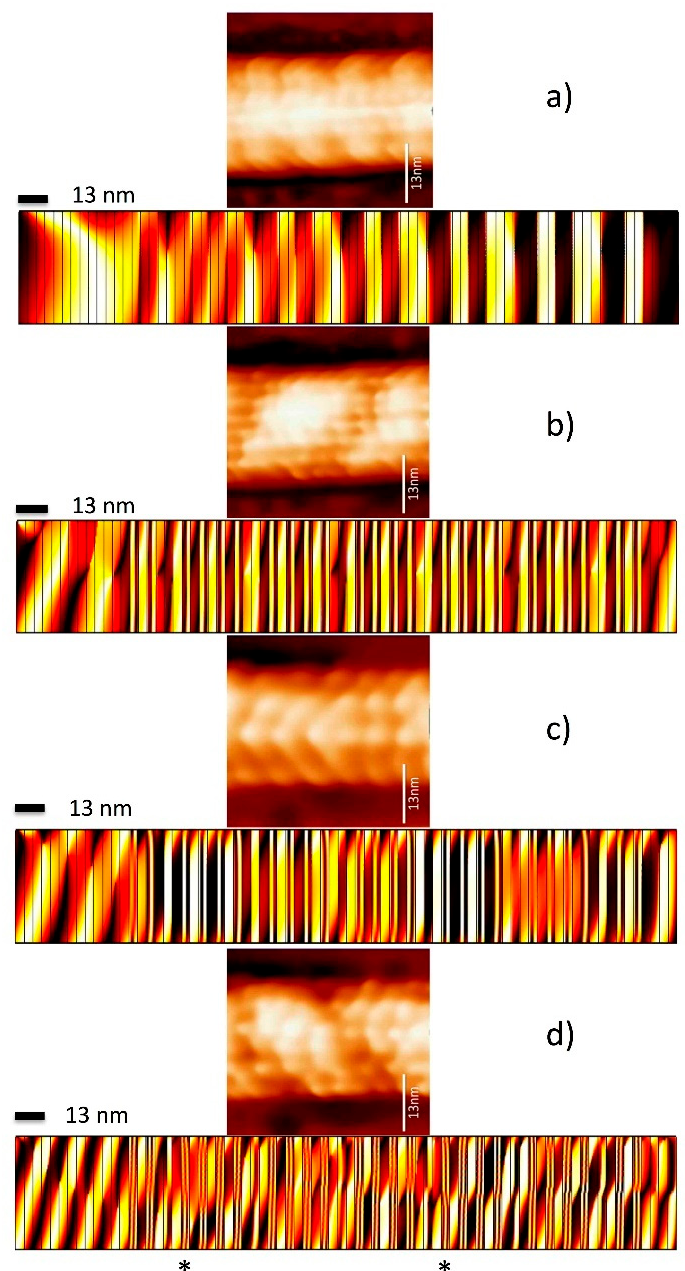
Figure 7. Finite element simulations of / (cid:107) H x + H y (cid:107) compared with experimental current distribution measurements at different frequencies [37]. ( a ) 30 MHz, ( b ) 101 MHz, ( c ) 113MHz, and ( d ) 185 MHz. The simulation shows similar patterns as the experimental current distributions for frequencies up to 113 MHz. Nonetheless, for the frequency of 185 MHz the experimental pattern is replicated only in two layers (shown by asterisks). Microtubule’s STM images are taken while pumping materials using a GHz antenna. We have described the experimental details in earlier works [21,22,29,37].